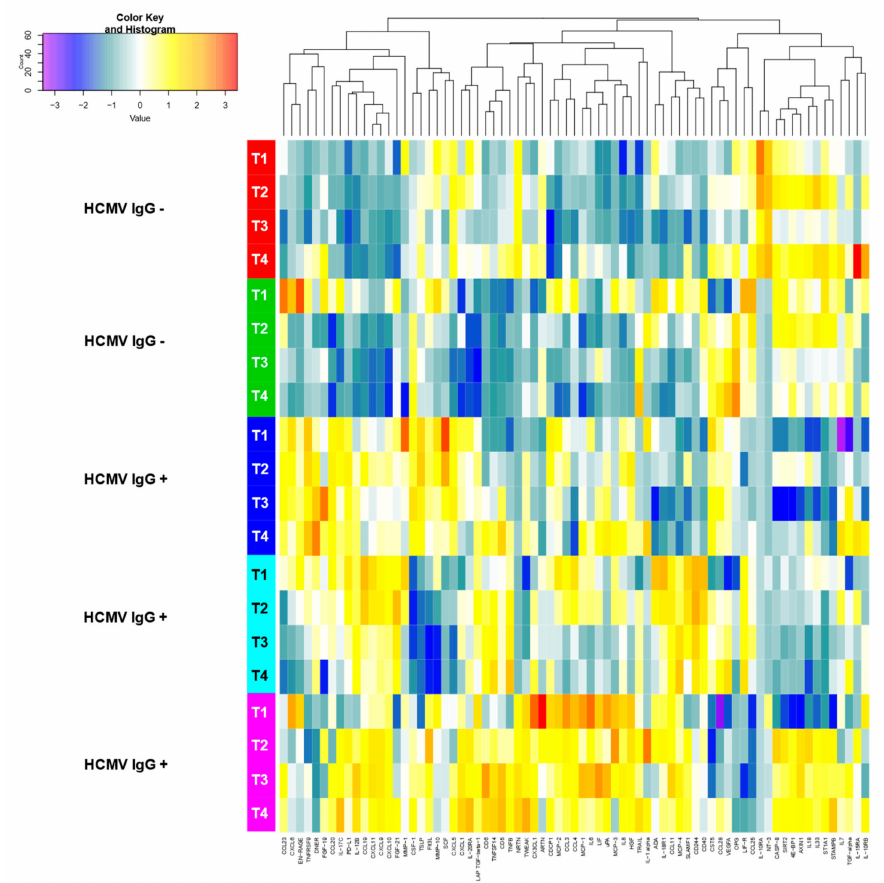
Figure A1. Heat map of longitudinal cytokine levels in milk whey of two IgG-seronegative and three IgG-seropositive mothers, obtained by Proximity Extension Assay technology. Four time ranges at weeks 2-3 (T1), 4-5 (T2), 6-7 (T3), and 8-9 (T4), after